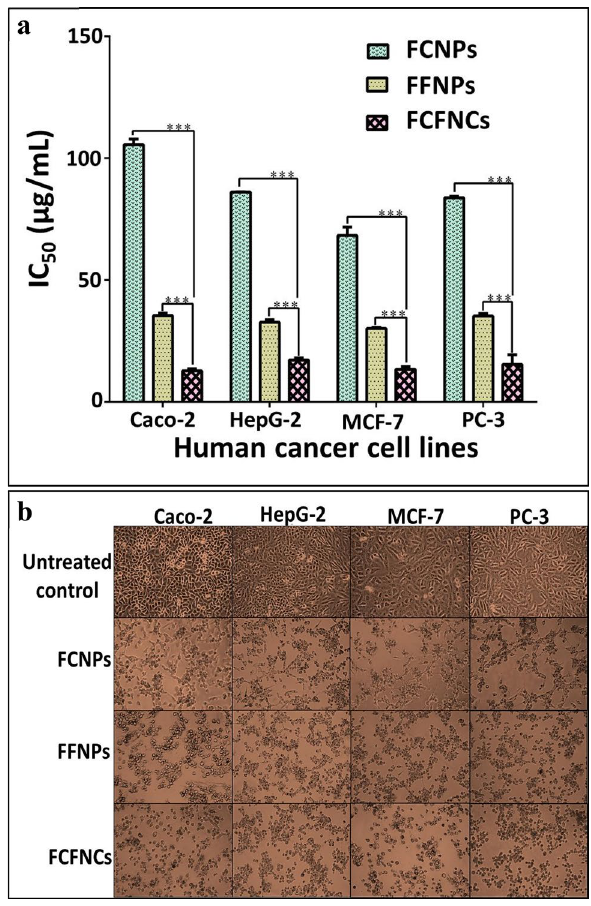
Figure 3. MTT results of the tested NPs against human cancer cells. IC 50 (μg/mL) values ( a ) with the morphological alterations of cancer cell lines after 72 h treatment with these tested NPs ( b ). All values were expressed as mean ± SEM. FCFNCs were compared with FCNPs and FFNPs. This comparison considers significantly different at *p < 0.05 , **p < 0.005, ***p <